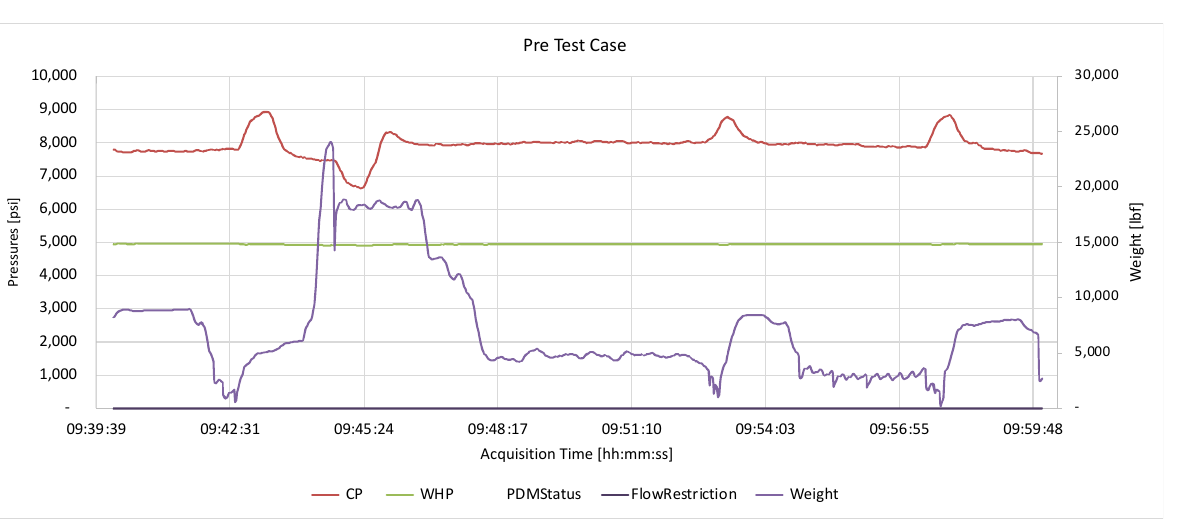
Figure 9. Plot for Pre-Test Case datapoints and FIS outputs.